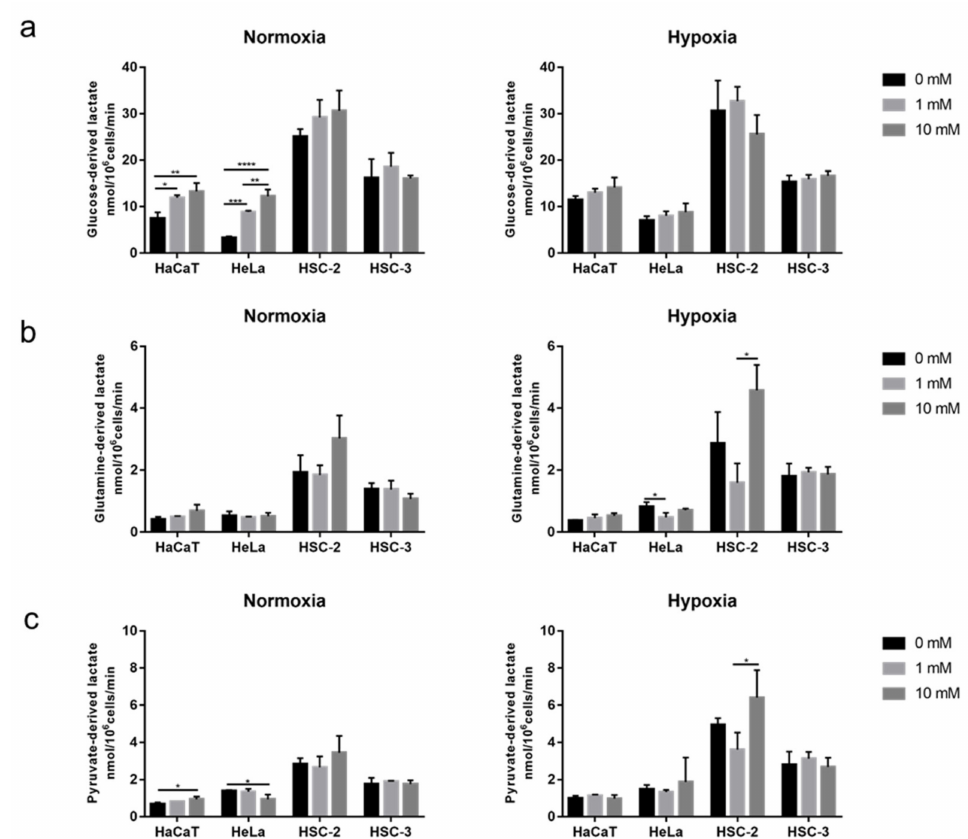
Figure 4. Modification of metabolic profiles during growth with metformin under normoxia and hypoxia. ( a ) Glucose-derived lactate in normoxia ( left ) and hypoxia ( right ). ( b ) Glutamine-derived lactate in normoxia ( left ) and hypoxia ( right ). ( c ) Pyruvate-derived lactate in normoxia ( left ) and hy- poxia ( right ). A one-way ANOVA and Tukey’s test. * p < 0.05, ** p < 0.01, *** p < 0.001, **** p < 0.0001. All experiments were independently performed in